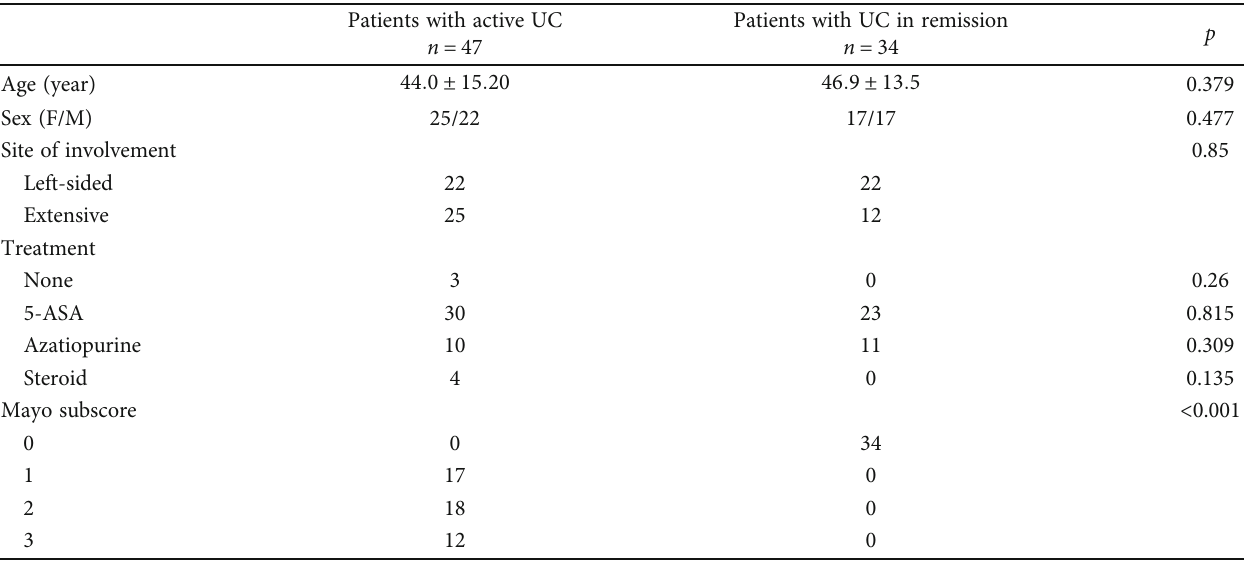
Table 1: Comparison of demographic, colonoscopic, and laboratory fi ndings between the patients with active ulcerative colitis and ulcerative colitis in remission.